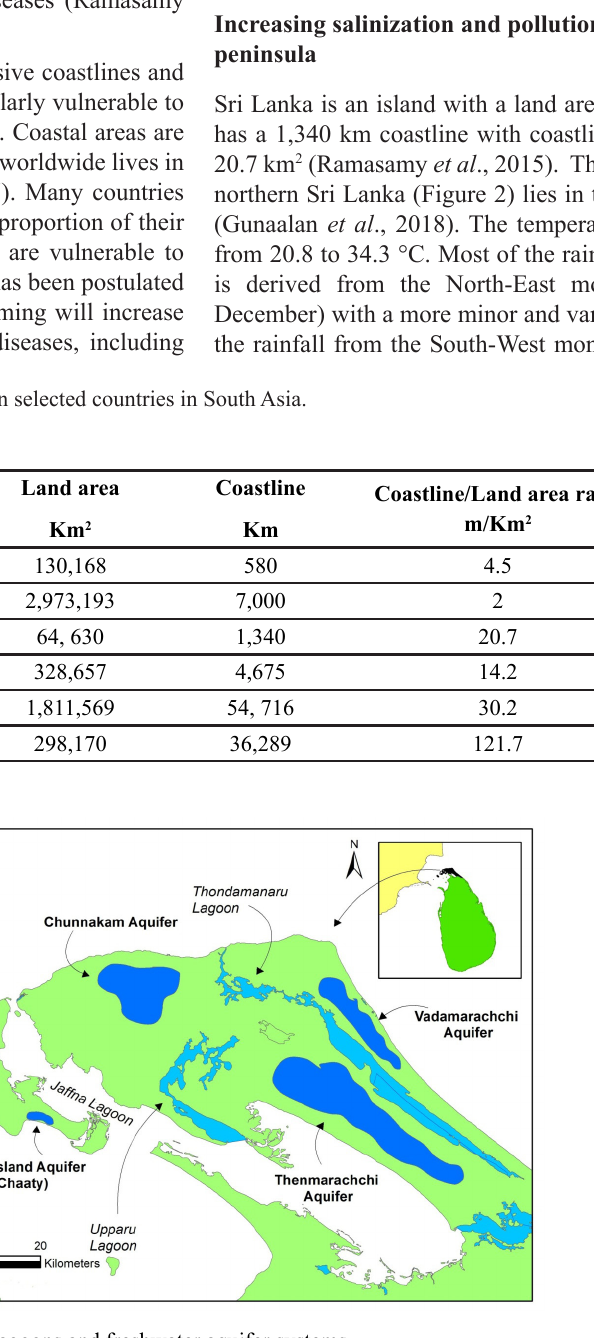
Figure 2: Map of Jaffna peninsula showing lagoons and freshwater aquifer systems. (Source: National Atlas of Sri